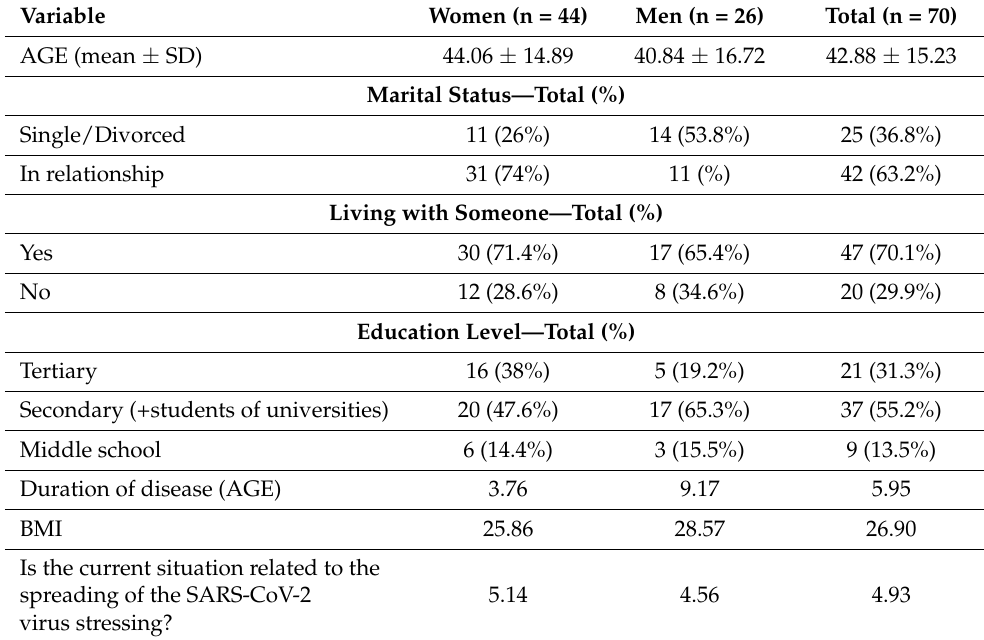
Table 1. Demographic characteristics of the